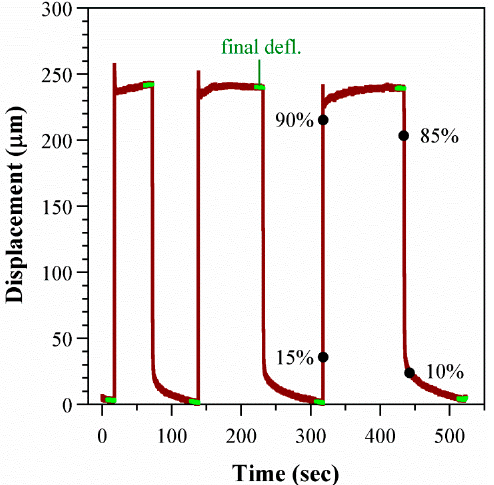
Figure 6. Membrane deflection over time in response to a cycle of three on/off pulses to 400 V (device 2). The points averaged to determine the deflection for each step are indicated (green), as are markers on one step illustrating the inflation values used to calculate τ r and τ f .